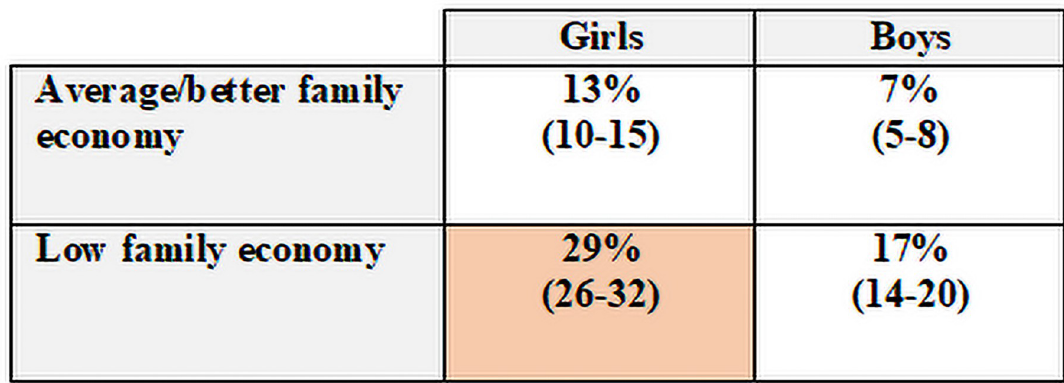
Fig 3. Risk profiles for persistent neck pain in young adulthood in Sample II (n = 832). Sample II = pain-free participants at baseline. Probabilities of persistent neck pain at follow-up (%, [95% CI]), red = highest risk